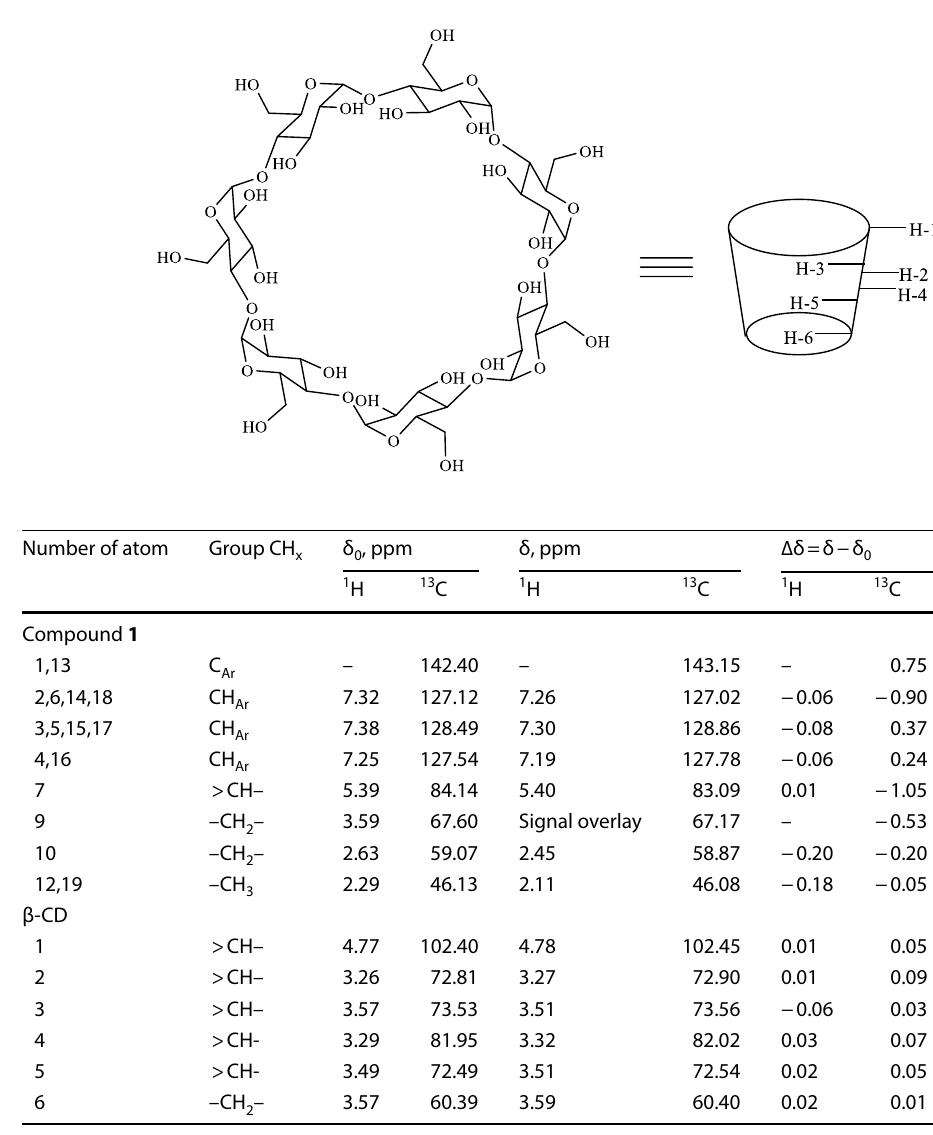
Fig. 2 Structure of β-CD. Drawn in ChemDraw